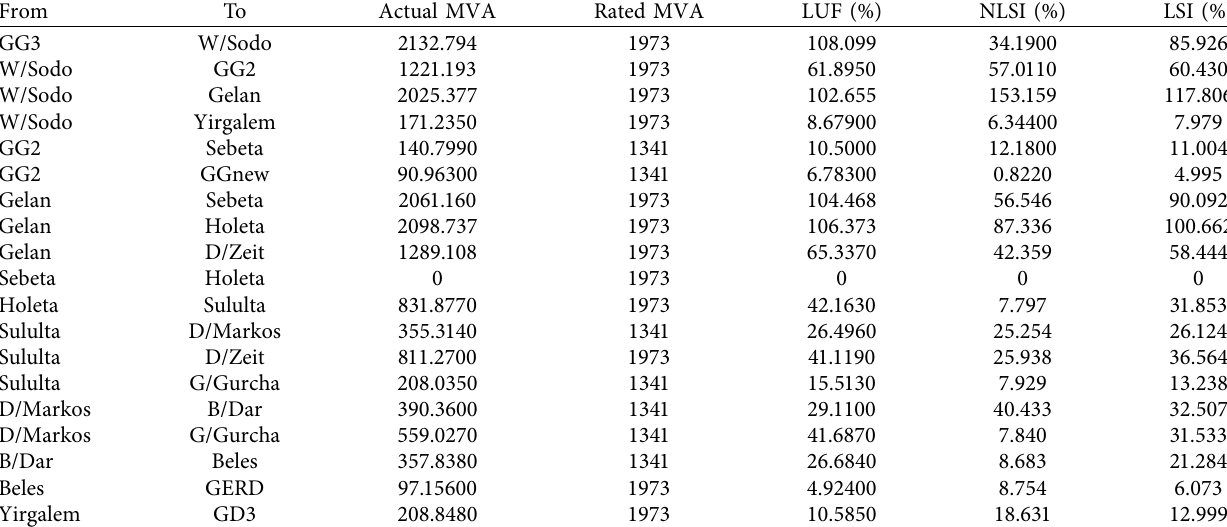
Table 7: LSI during an outage of Sebeta to the Holeta branch without